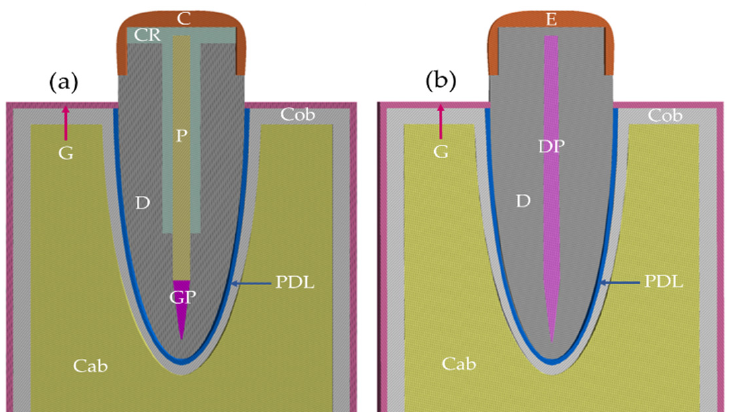
Figure 1. Schematic of tooth models: ( a ) tooth restored with glass fiber post (GF-reinforced poly(BA-a) composite, ( b ) natural tooth; C—Porcelain crown, CR—Composite resin, D—Dentin, DP—Dental pulp, P—Post, GP—Gutta-percha, E—Enamel, Cob—Cortical bone, Cab—Cancellous bone, PDL—Periodontal ligament. Table 1. Summarized elastic properties of the isotropic materials used for the FEA.